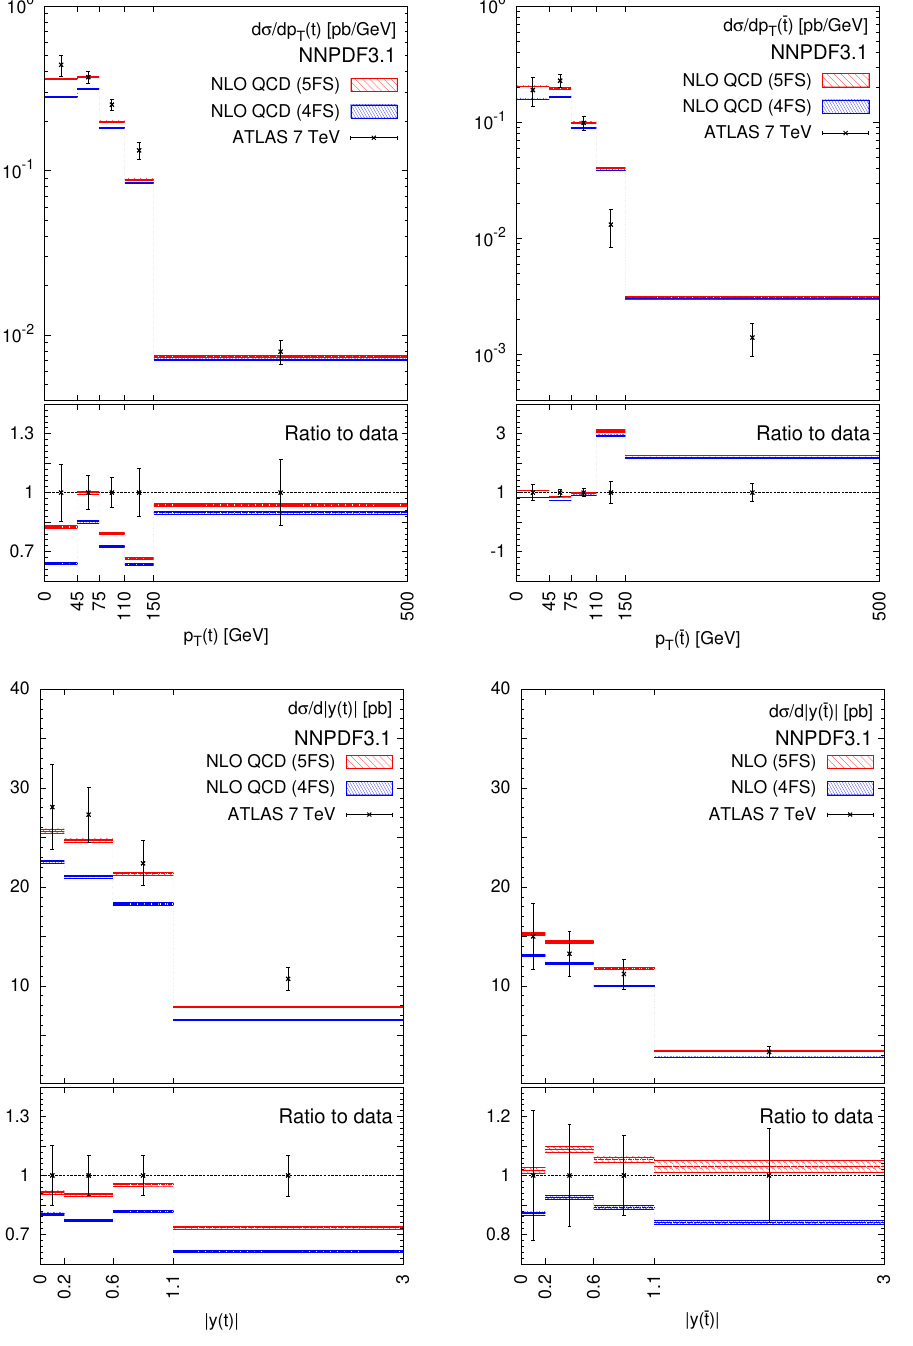
Figure 7 . Same as (cid:12)gure 3, but comparing NLO predictions in the 4FS and 5FS.